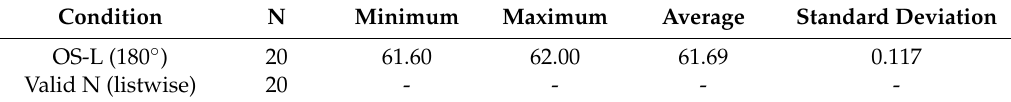
Figure 19. Empirical noise level (OS-L) of 180 ◦ oriented building toward runway. Table 19. Descriptive Statistics of empirical noise on the 180 ◦ oriented building to